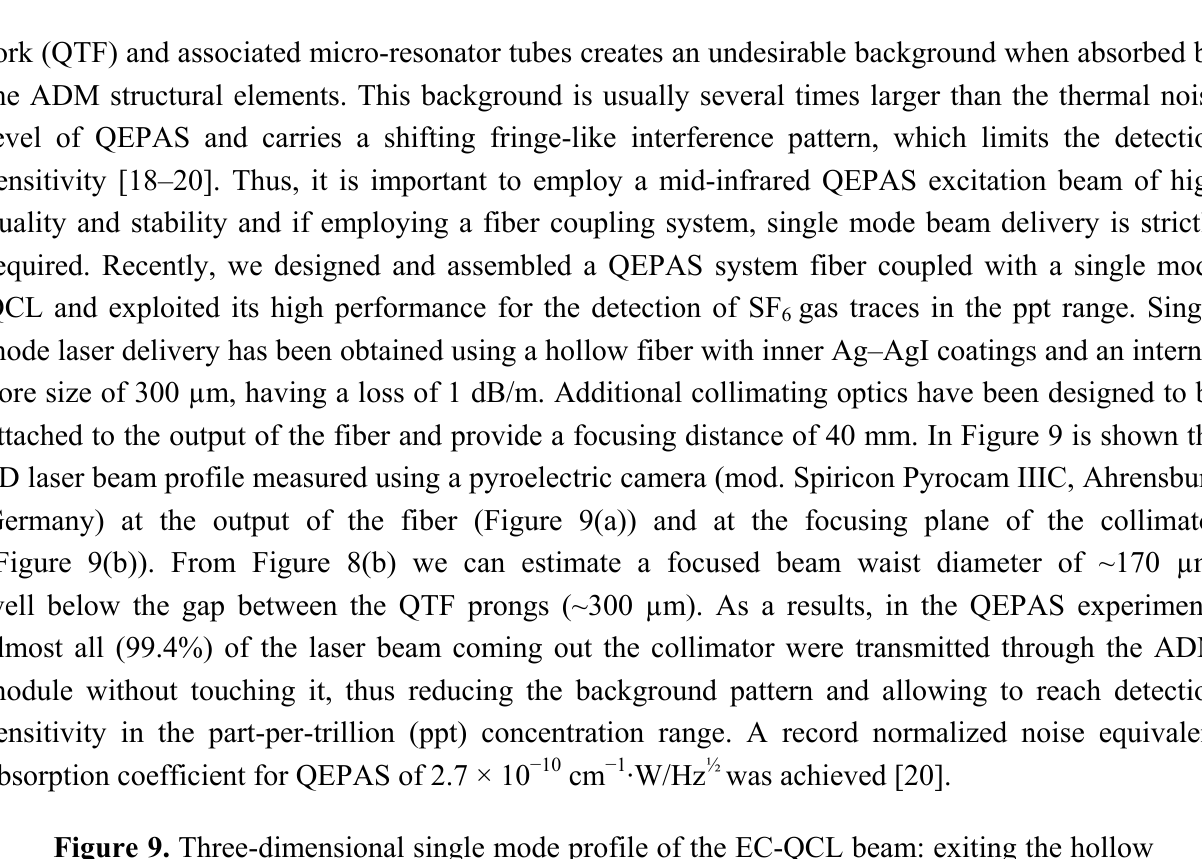
Figure 9. Three-dimensional single mode profile of the EC-QCL beam: exiting the hollow fiber ( a ) and at the focusing plane of the collimator ( b ). The color map, identical for both panels, is shown in right side of the